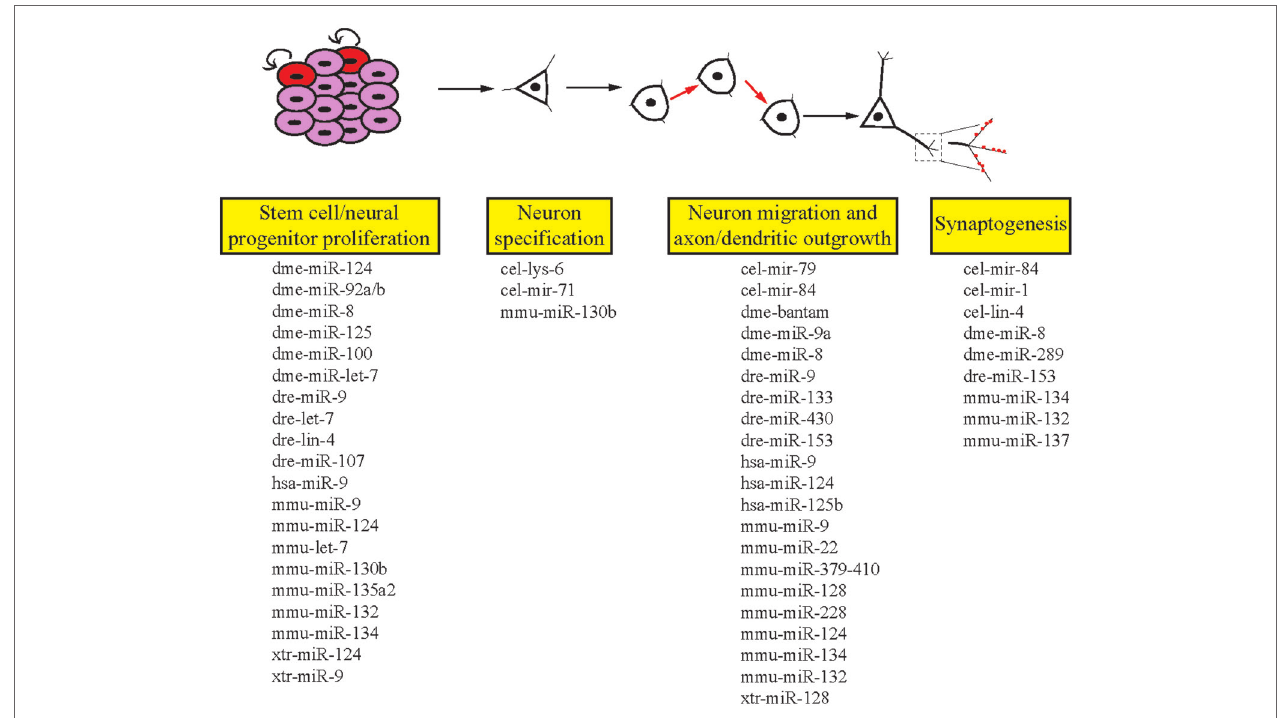
FiGURe 2 | Roles of miRNAs in different stages of neuronal development . miRNAs are involved in the multiple stages of neuronal development in invertebrates and vertebrates. Listed here are the miRNAs we cover in this review that regulate single or multiple stages of neuronal development. cel, Caenorhabditis elegans ; dme, Drosophila melanogaster ; dre, Danio rerio ; hsa, Homo sapiens ; mmu, Mus musculus ; xtr, Xenopus tropicalis